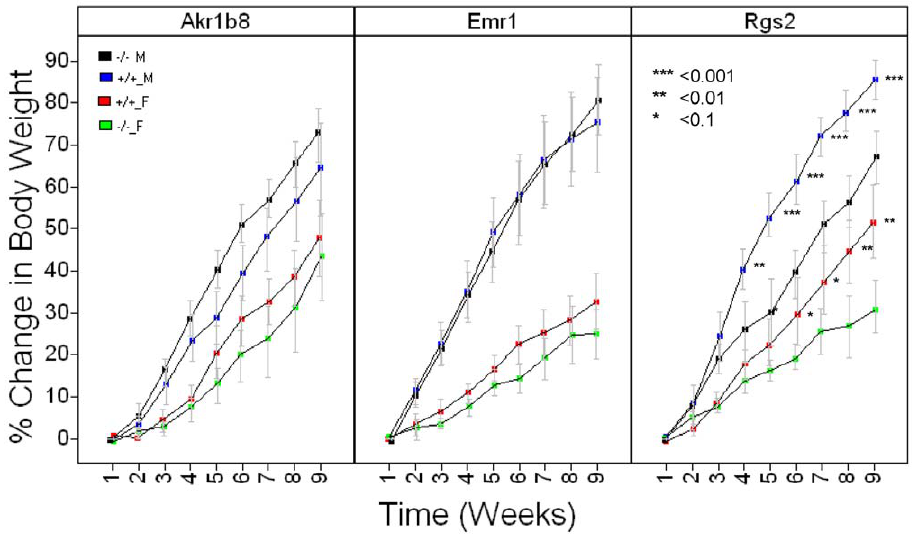
9 weeks. Statistically significant differences between genotypic groups split by gender are marked. Blue =WT males; Black =KO males; Red=WT females; Green = KO females. *actual number of Emr1 + / + female mice =8. # actual number of Rgs2 2 / 2 female mice=6.